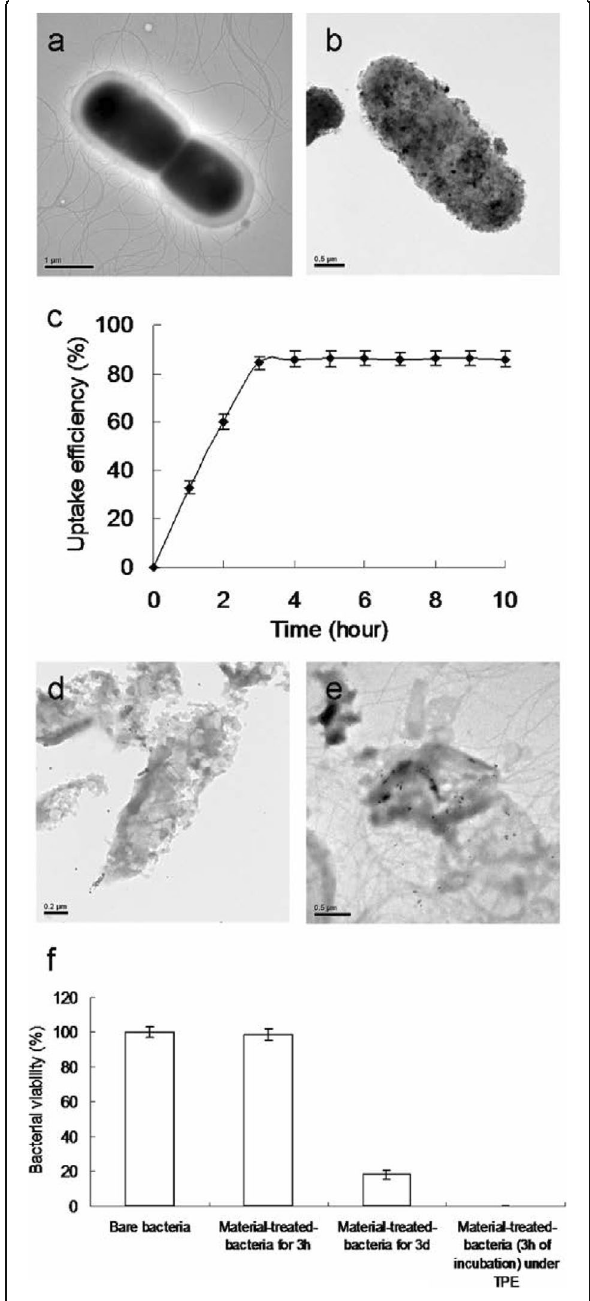
Fig. 5 TEM images. a Showing bare bacteria without any treatment. Bacteria treated with material for b 3 h and d 3 days of incubation. e The photoexcited material-treated bacteria (3 h of incubation) with a TPE power of 211.2 nJ pixel − 1 with 800 scans (approximately 3.2621 s of total effective exposure time; Ex, 760 nm). c Uptake assay of bacteria and material at 37 °C. f Viability (%) was quantified following the determined viable count of material-treated bacteria via CFU assay by short excitation with the same treatment. Delivered dose OD600 ~ 0.05 of E. coli and 3 μ g mL − 1 water-soluble fullerenol C 60 (OH) 46 . Data are means ± SD ( n =